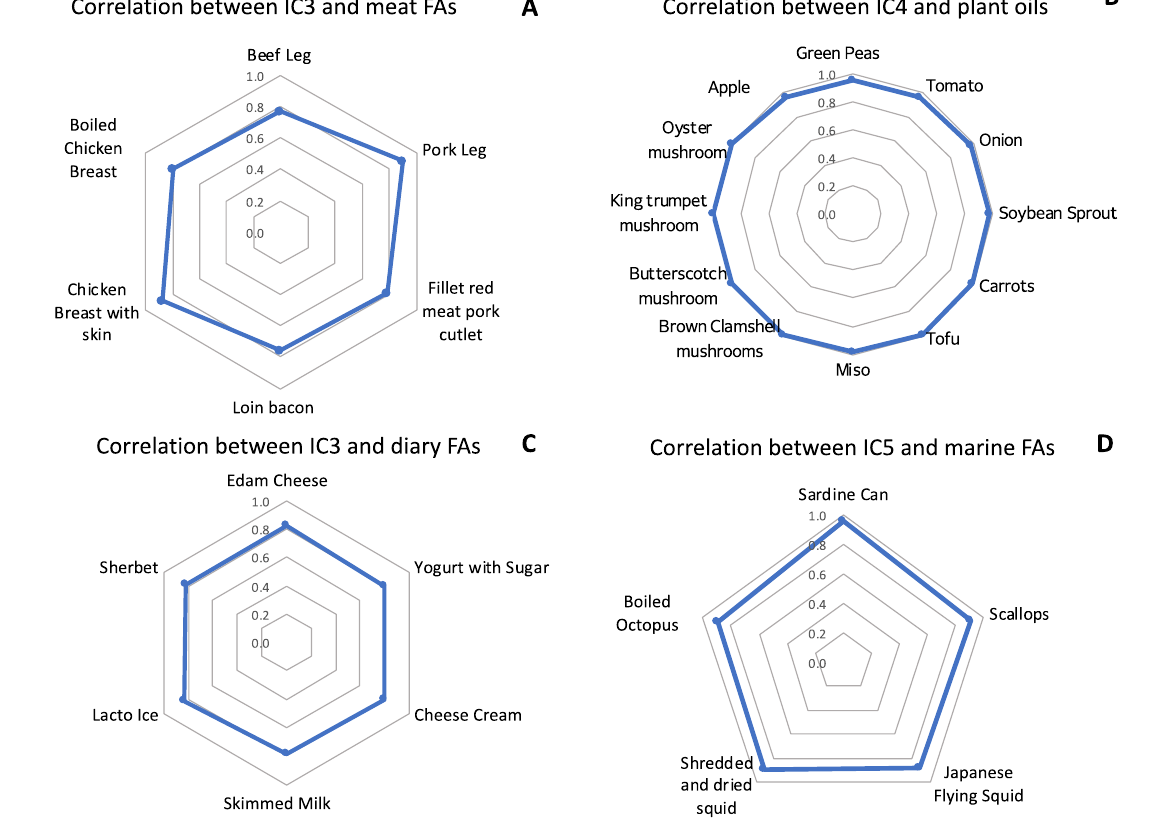
Figure 5. Diagram of suggested food sources. We calculated the correlation coefficients (CCs) between the loading values in the ICA results and the published FA composition in foods 29 . Then, we selected the foods with the top 10 highest CCs in four major food sources of animal meats ( A ), plants ( B ), dairy products ( C ), and marine foods ( D